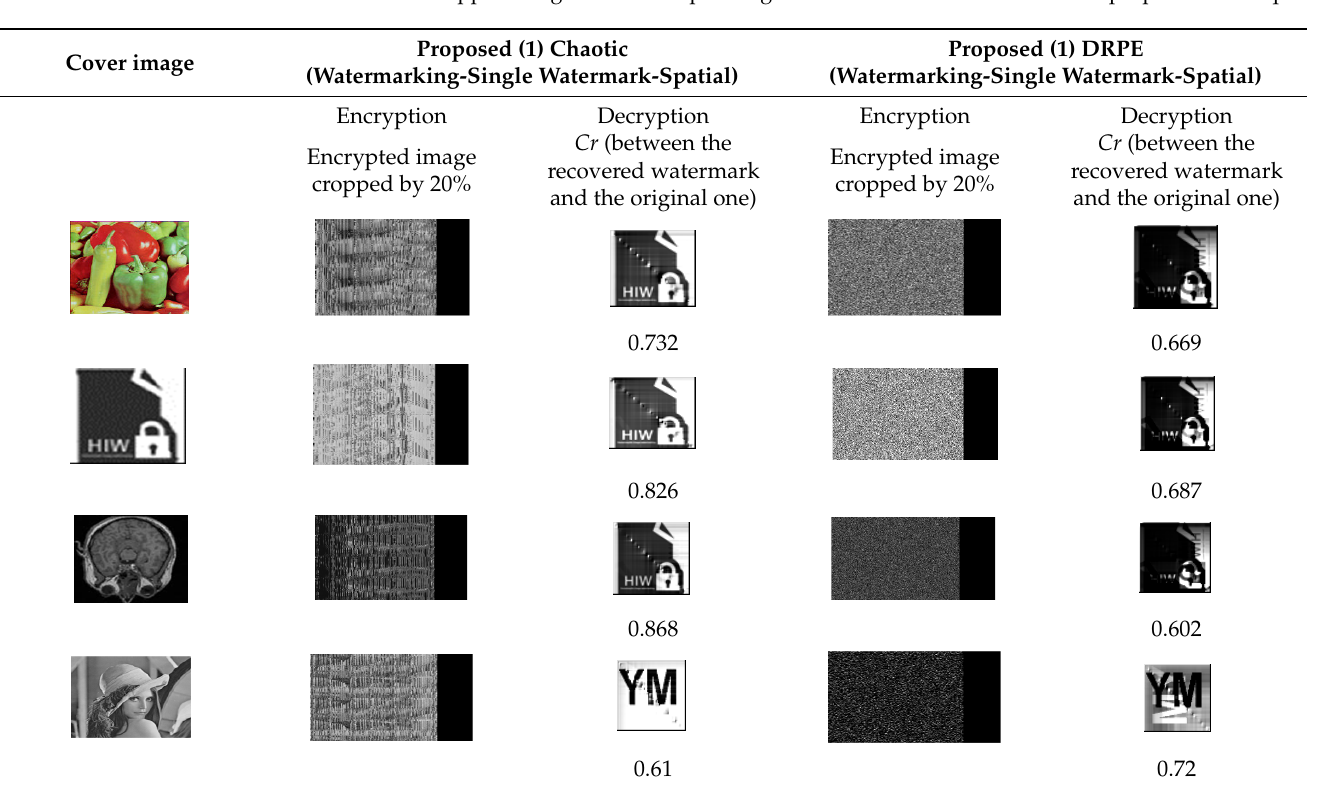
Table 13. Cropped images and corresponding extracted watermarks for the first proposed